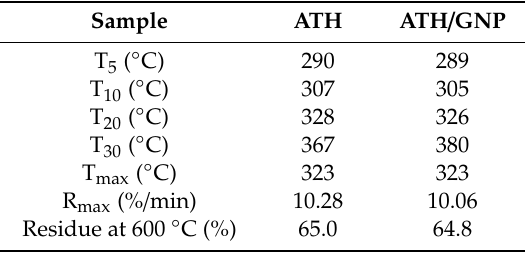
Table 1. TG data of ATH and ATH/GNP.